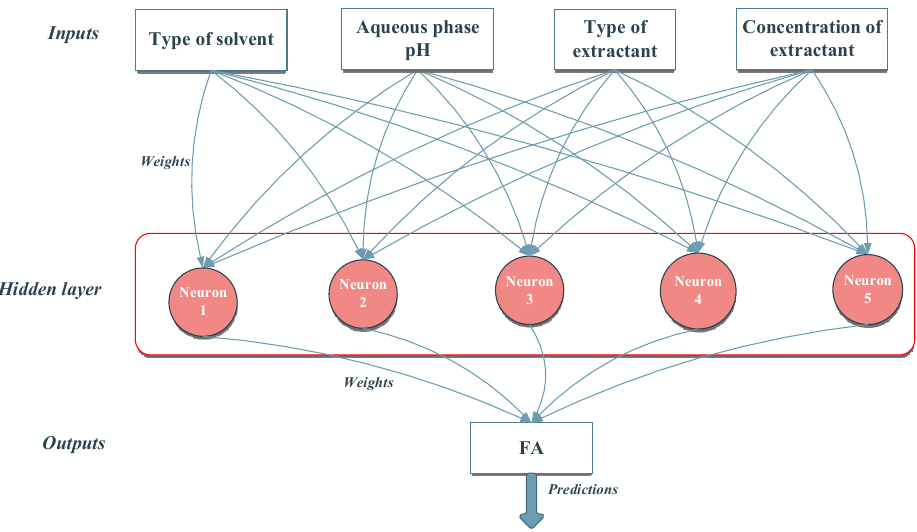
Figure 6. Topology of the best ANN model obtained.